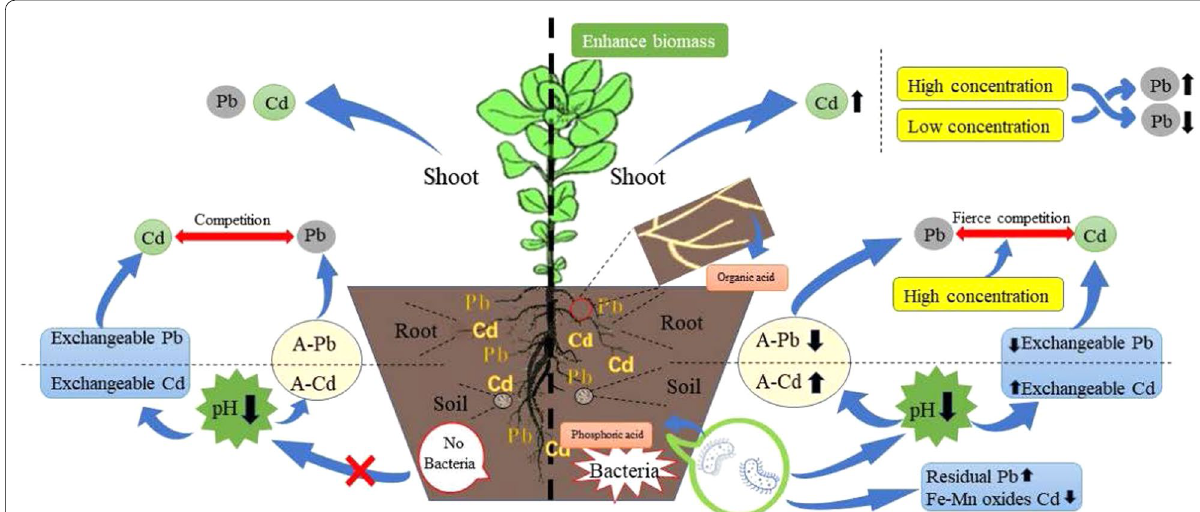
Fig. 6 Mechanism of resistant bacteria affecting Pb and Cd absorption by Sedum alfredii Hance . The graph on the right shows the changes in the fugitive patterns of heavy metals Pb and Cd in the soil and the Pb and Cd content of Sedum alfredii Hance with the addition of resistant bacteria. The left side of the figure shows the change of Pb and Cd without the addition of resistant bacteria. The upward arrows indicate an increase and the downward the opposite. A-Pb indicates the effective state of Pb; A-Cd indicates the effective state of